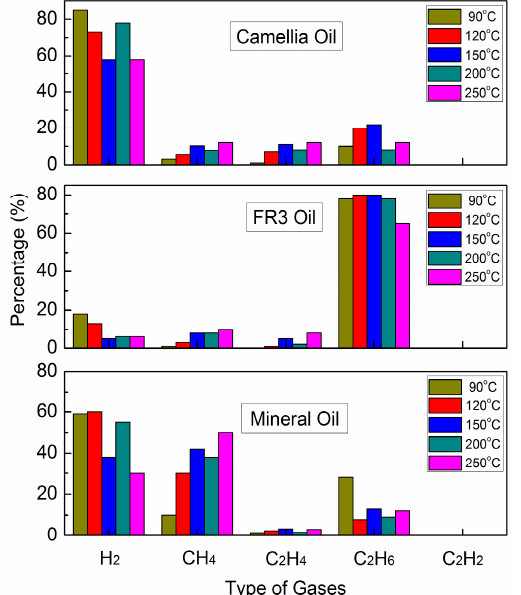
Figure 8. Relative percentages of fault gases in oil-paper insulation as a function of oven temperature (from 90 °C to 250 °C).